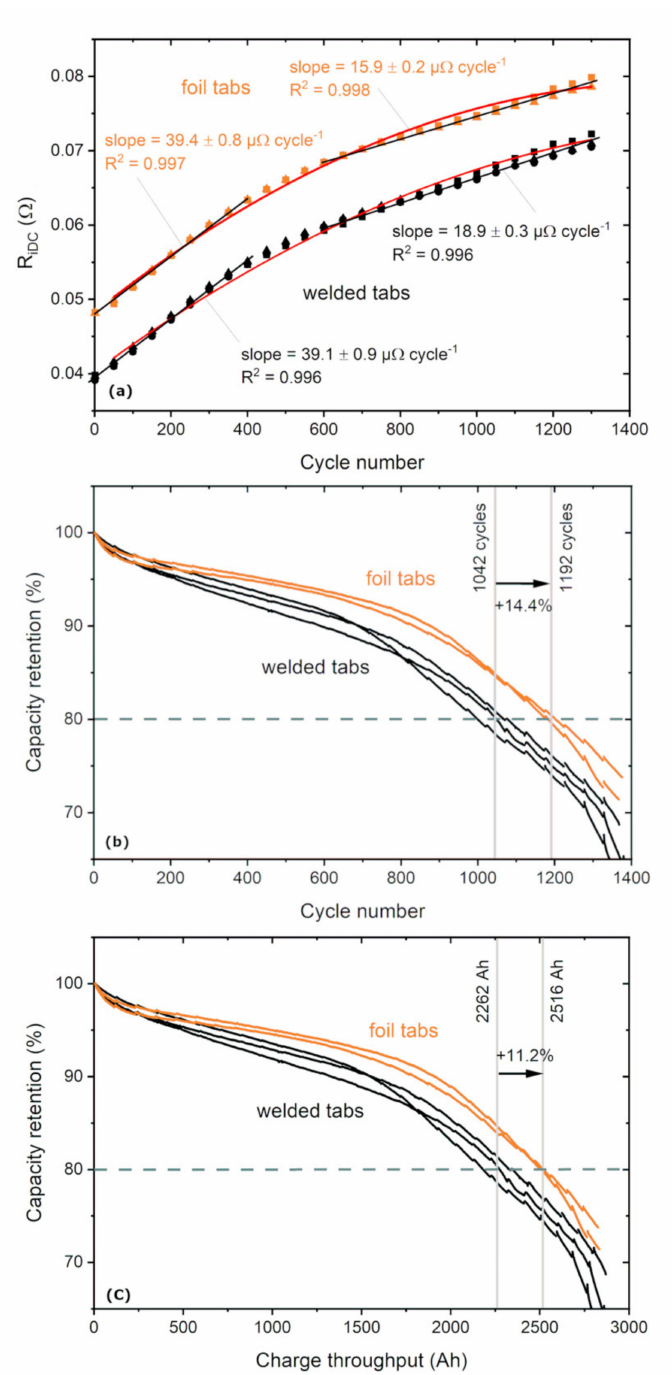
Figure 4. ( a ) Resistance increase and ( b ) capacity retention during long-term cycling aging as a function of cycles and ( c ) as a function of charge throughput (discharge). The black solid lines in ( a ) are linear fits from cycle 1 to 400 and cycle 600 to 1300. The red dashed lines in ( a ) are fitted polynomial functions of second